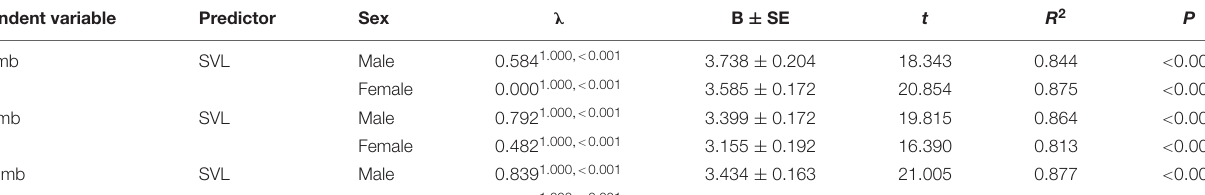
TABLE 1 | Relationship between limb muscle mass and body size (SVL) in both males and females among species of anurans. Dependent variable